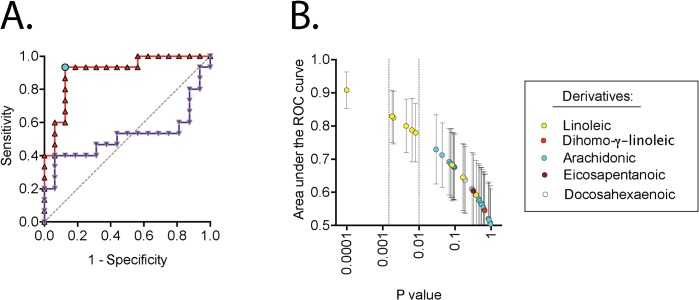
Receiver operated curves (ROC) for the oxylipins.In Panel A, two individual examples are shown for 12,13-DiHOME (red line) and 11-HETE (purple line). The area under the ROC curves for these lipids were 0.91 (95% CI 0.80–1.02, P = 0.0001) and 0.52 (95% CI 0.29–0.74, P = 0.87), respectively. The dotted line is for an area under the ROC curve of 0.5, i.e. no predictive value. The turquoise circle in the ROC curve for 12,13-DiHOME shows the optimum cut-off value (the Youden score). In Panel B, the area under the ROC curves (means ± SE) are plotted against the P values from the ROC analyses for all the oxylipins, colour-coded upon the basis of the fatty acid group to which they belong. The vertical lines delineate P values of 0.00147 (= 0.05/34) and 0.01. The three oxylipins with the highest P value and area under the ROC curves are (left to right) 12,13-DiHOME, 13-HODE and 9,10,13-TriHOME.